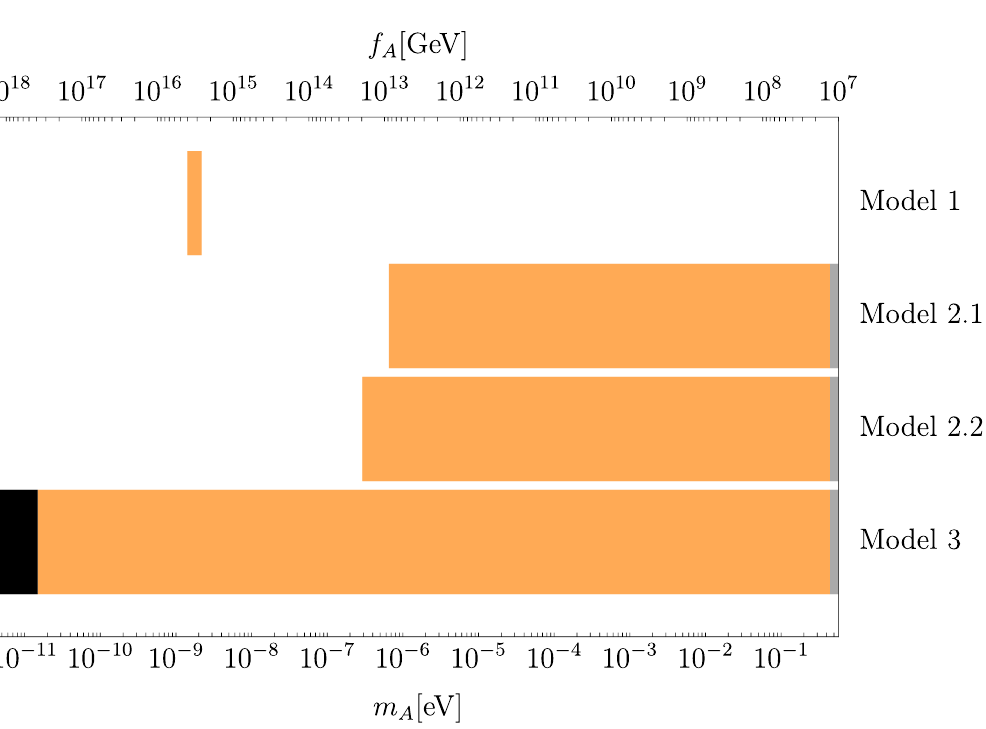
Figure 11 . Viable ranges of f A in the hypothetical case of a known proton lifetime between 1 : 6 (cid:2) 10 34 and 1 : 3 (cid:2) 10 35 years. Allowed regions are plotted in orange. Regions in black are